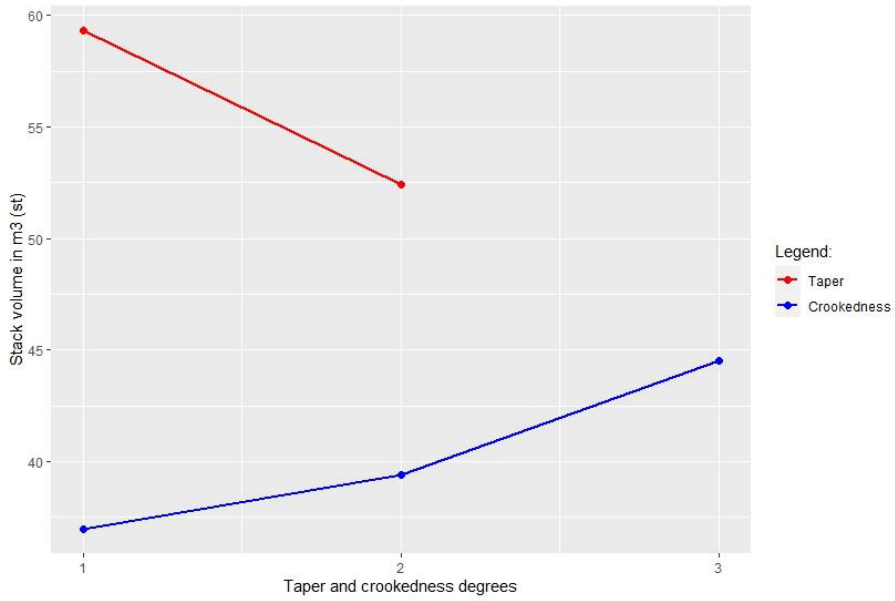
Figure 4. Stack volume variation according to increasing tapering and crookedness degrees.